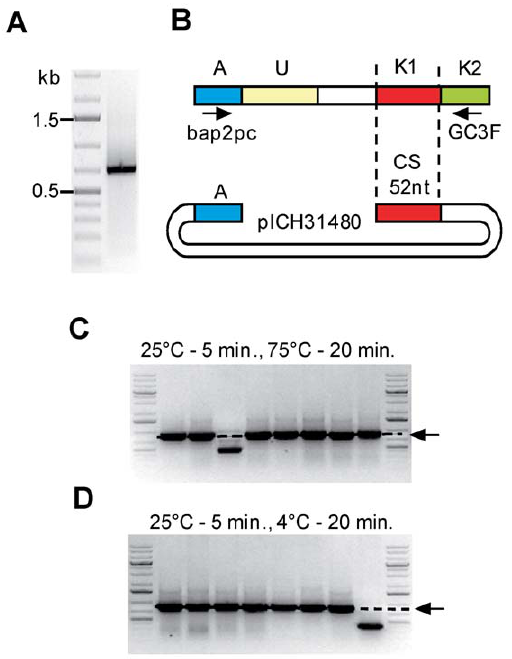
Figure 4. Test of QC cloning performed with or without heat inactivation. ( A ) PCR product amplified from G-tailed cDNA prepared from biopsy sample T019 using primers bap2 pc and GC3F. ( B ) Structure of the vector and of the PCR product. ( C , D ) The PCR product was cloned into pICH31480 using T4 DNA polymerase treatment for 5 minutes at 25 u C (A, adaptor; U, unknown sequence; K, known sequence; CS, catching sequence), followed by heat inactivation 20 min at 75 u C ( C ) or incubation at 4 u C ( D ). Eight randomly chosen clones were analyzed by colony PCR using vector primers. The products amplified by colony PCR were separated on a 1% agarose gel supplemented with ethidium bromide and visualized under UV light. The expected insert size is indicated by an